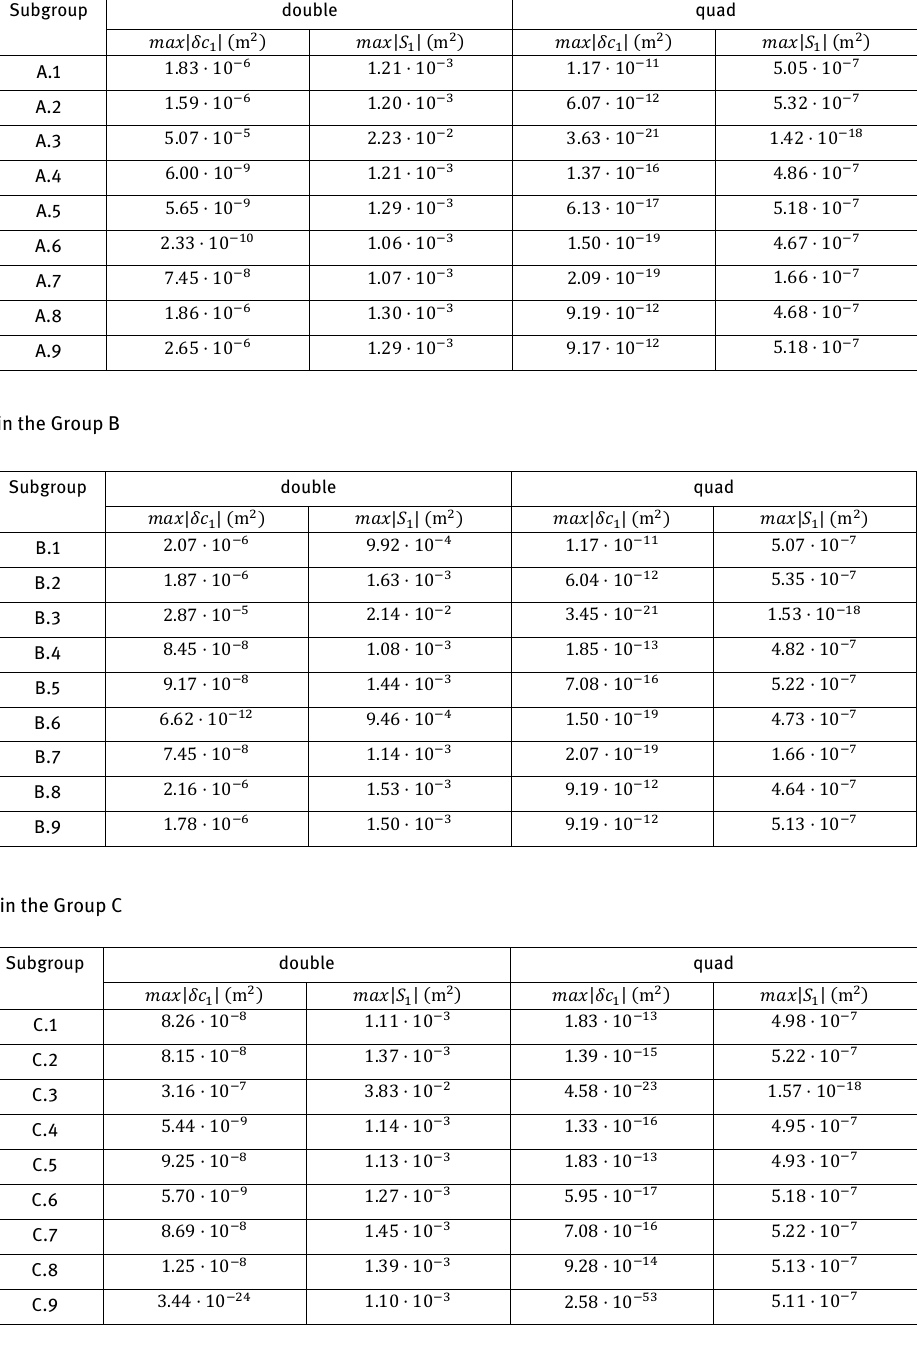
Table 10: Results in the Group A Subgroup